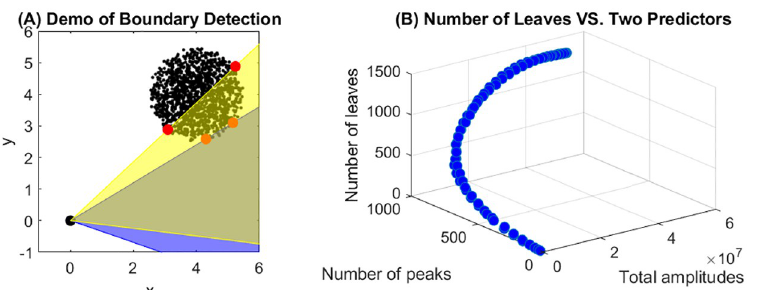
Fig 3. Estimation of the surroundings. (A) A demonstration of detecting boundary points of a ball-shaped leaf cluster at two azimuth angles. (B) Relationship between the number of leaves and two of the predictor variables: the total amplitudes and the number of